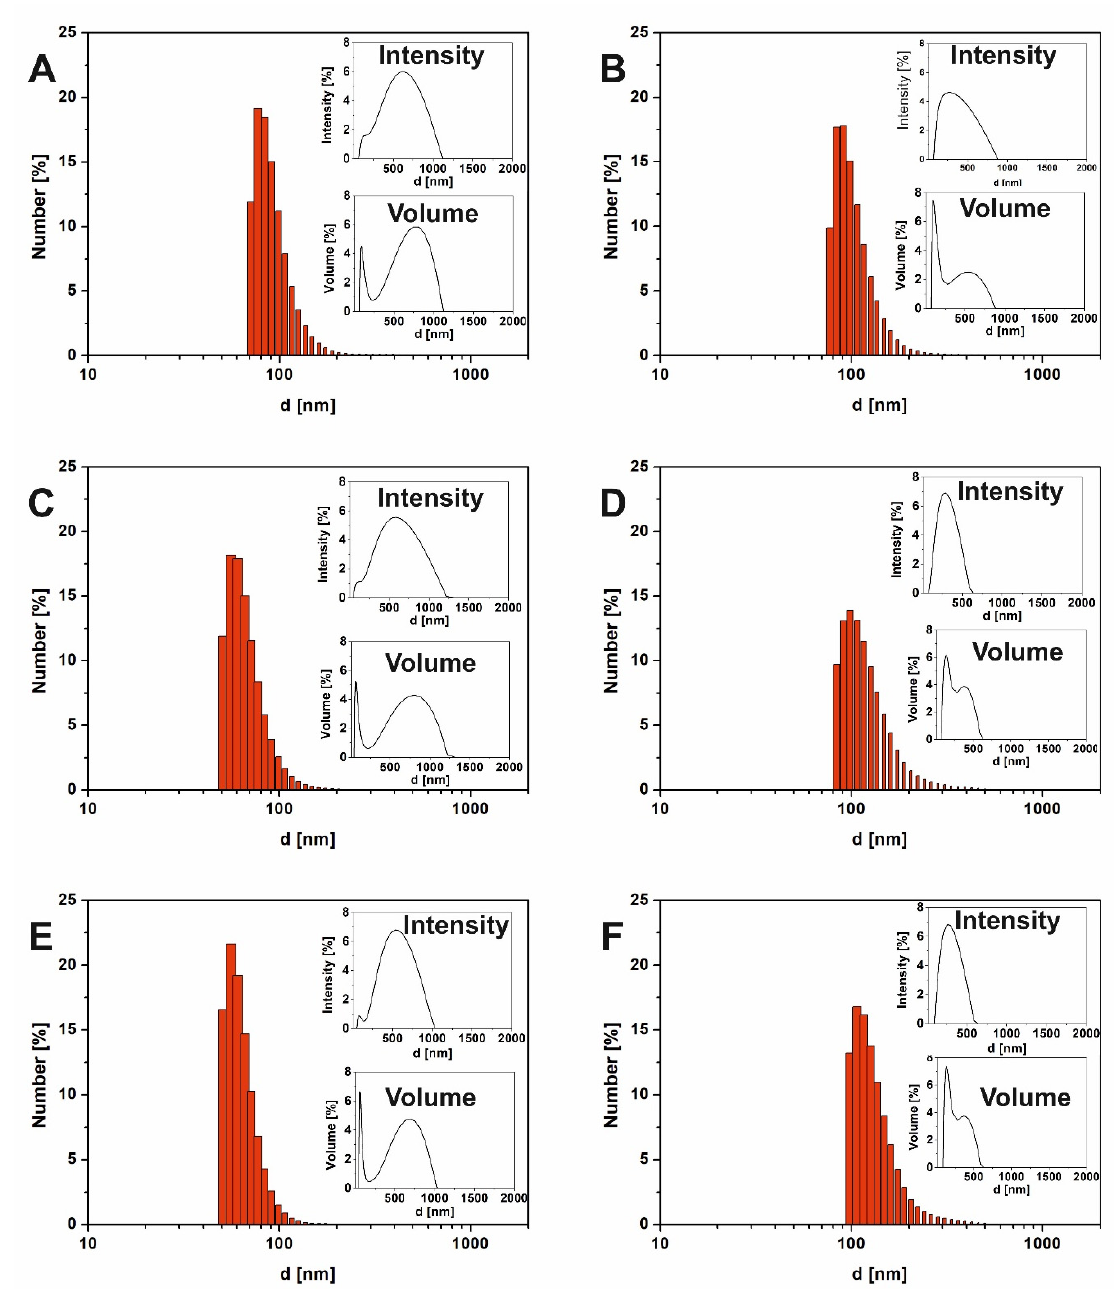
Figure 3. Droplet size distribution by number, intensity and volume obtained by dynamic light scattering (DLS): oil-in-water (O / W) without surfactant emulsion ( A ) after 24 h, ( B ) after 1 week; emulsion with Quillaja extract ( C ) after 24 h, ( D ) after 1 week; emulsion with Saponaria extract ( E ) after 24 h, ( F ) after 1 week.